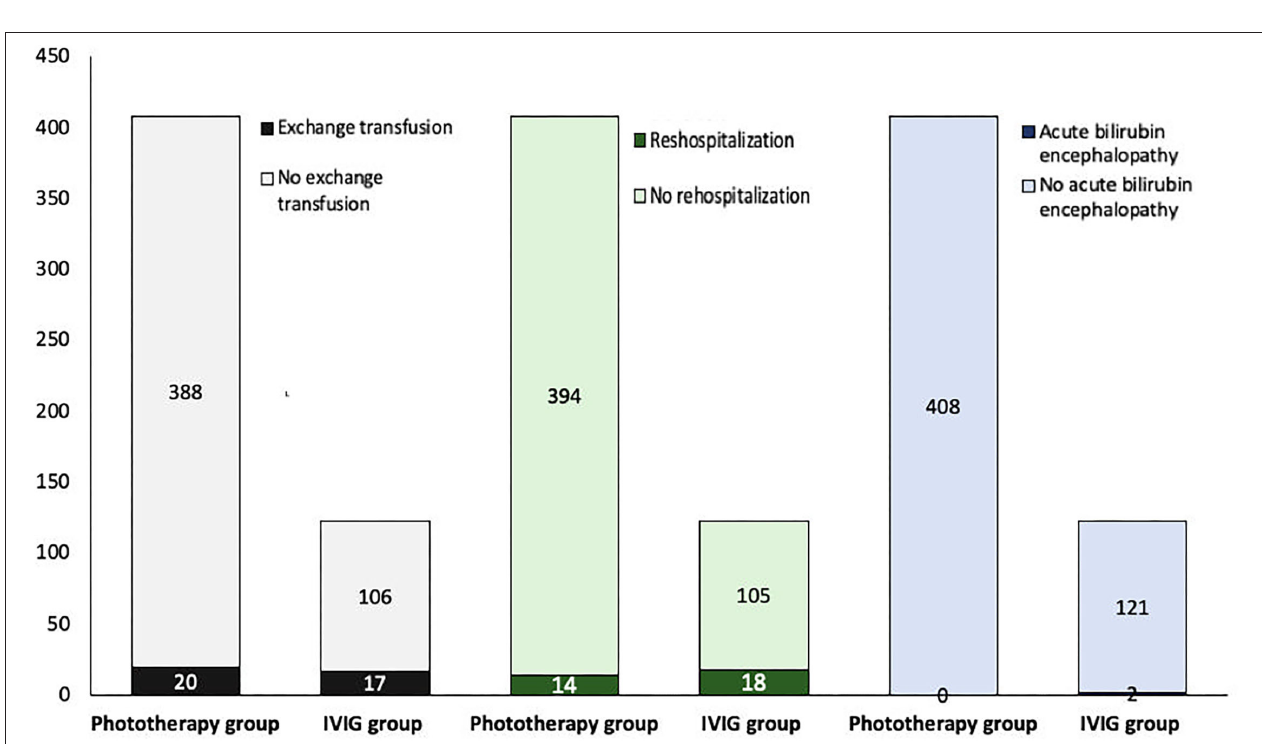
Frontiers in Pediatrics |